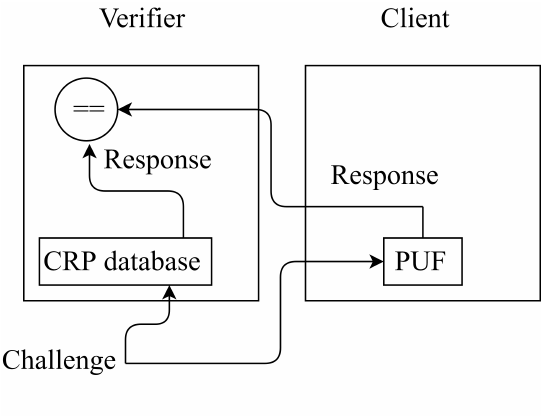
Figure 1. Typical strong PUF-based authentication